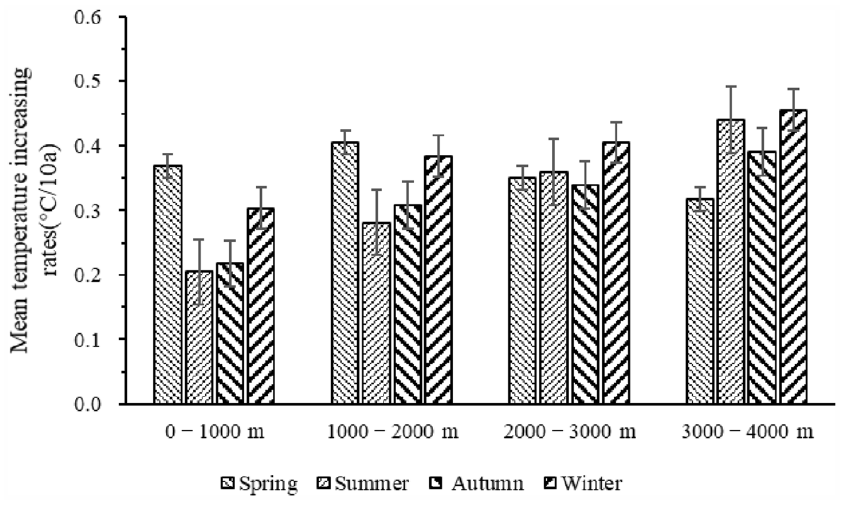
Figure 4. Seasonal rate of increase in air temperature at different elevations in the Qinling–Daba mountains during 1969–2018.